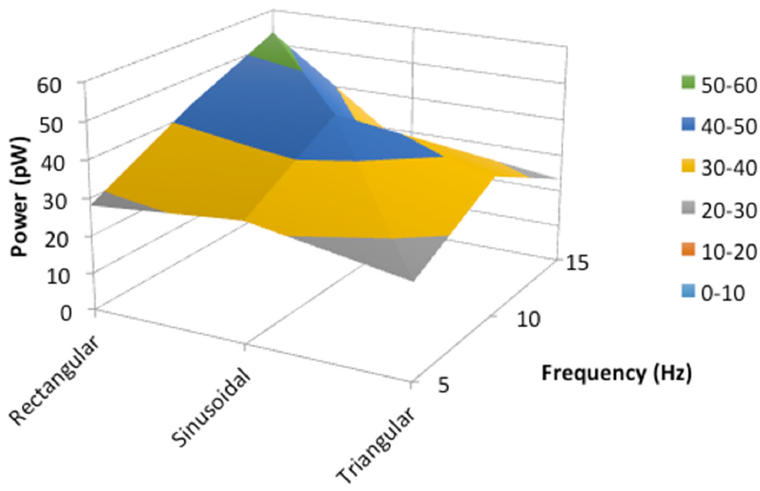
Figure 8. Maximum power of the oscillation movement against the three external frequencies and waveforms.